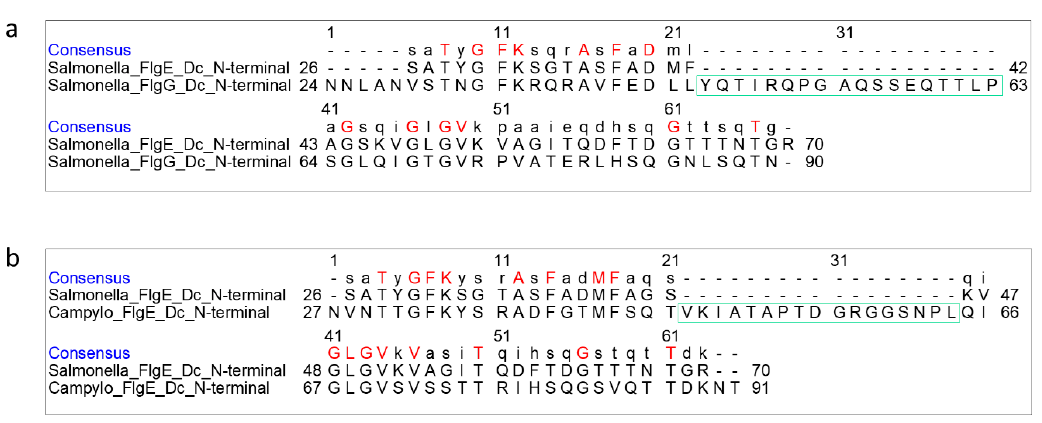
Figure 4. Pairwise sequence alignment of FlgE and FlgG in the domain Dc region. ( a ) Sequence alignment between Salmonella FlgE and FlgG, and ( b ) between Salmonella FlgE and Campylobacter FlgE. The 18 and 17 residue insertions in Salmonella FlgG and Campylobacter FlgE, respectively, are boxed in green.